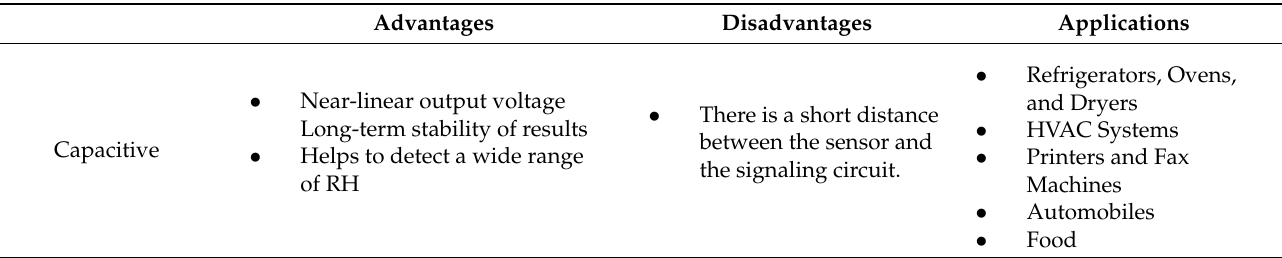
Table 1. Types of humidity